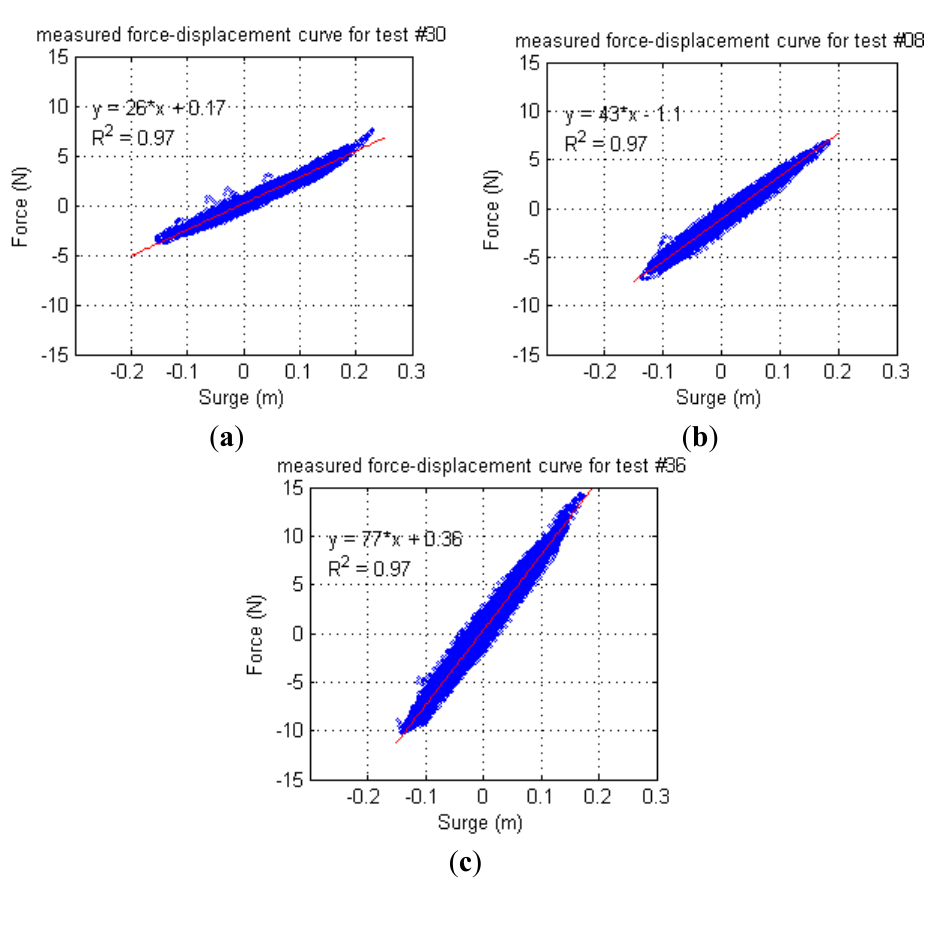
Figure 11. F-D curves measured in design wave conditions ( T